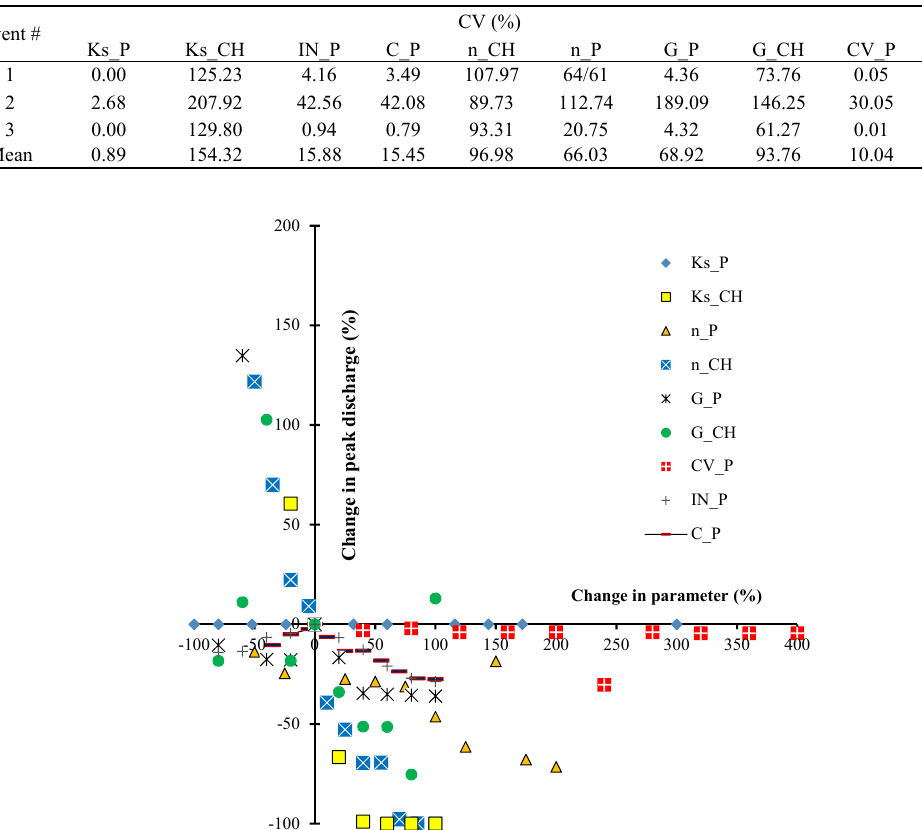
Where, discharges at time pace i respectively, of measured flow in the simulation period, describe the standard deviations of measured and predicted discharges respectively, r is correlation coefficient between measured and predicted data, and n is number of observations in the prediction interval.